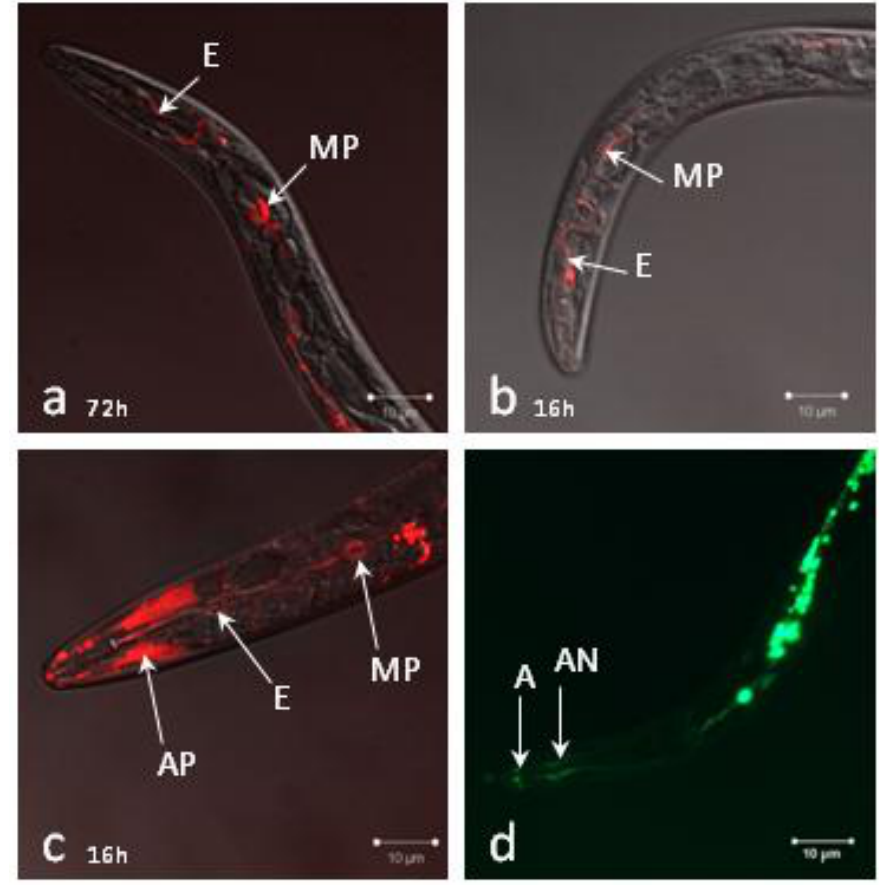
Figure 1. Localization of siRNA uptake in J2 larvae. A fluorescently labeled 21 bp-long dsRNA was visualized in J2s ( a ) after soaking for 72 hours in the presence of lipofectamine; ( b ) after soaking for 1 hour in the presence of lipofectamine and serotonin, washing and incubation for an additional 16 hours in water; or ( c ) after soaking for 1 hour in the presence of lipofectamine and glutamate. (d) FITC uptake was visualized after 1 hour soaking in lipofectamine and glutamate. A: amphid, AP: amphidial pouch, AN: amphidial nerve bundle, E: esophageal duct, MP: metacorpus